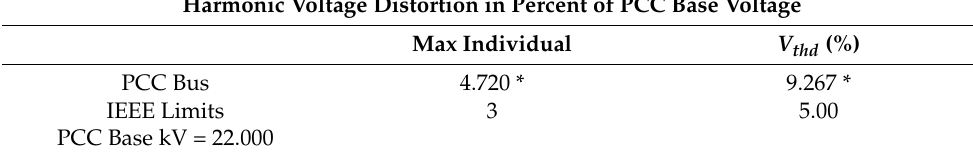
Table 7. ESA calculation results for IEEE Std. 519 current report without filter-2.